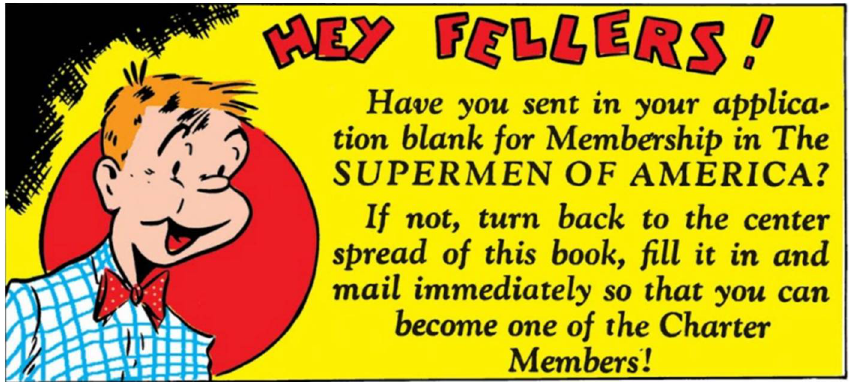
Figure 17. Joe Shuster, Closing Panel: “Hey Fellers!” (panel No. 96), 1938. Siegel and Shuster (August 1938), “Superman”, Action Comics #3 (Siegel and Shuster 1938c, p. 48). © DC Comics.